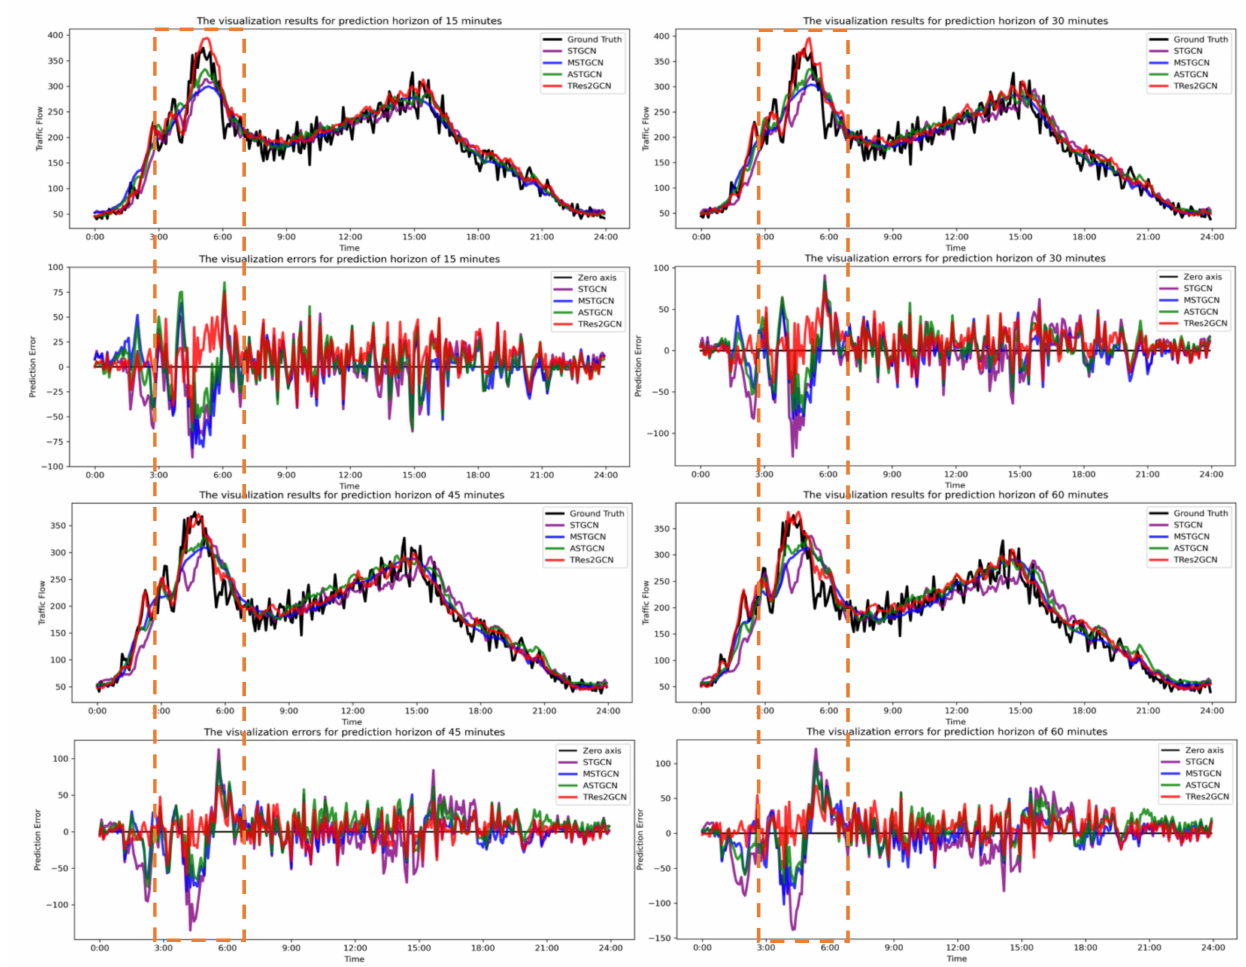
Figure 5. Visualization of prediction results and errors ranging 0–60-min span of sensor